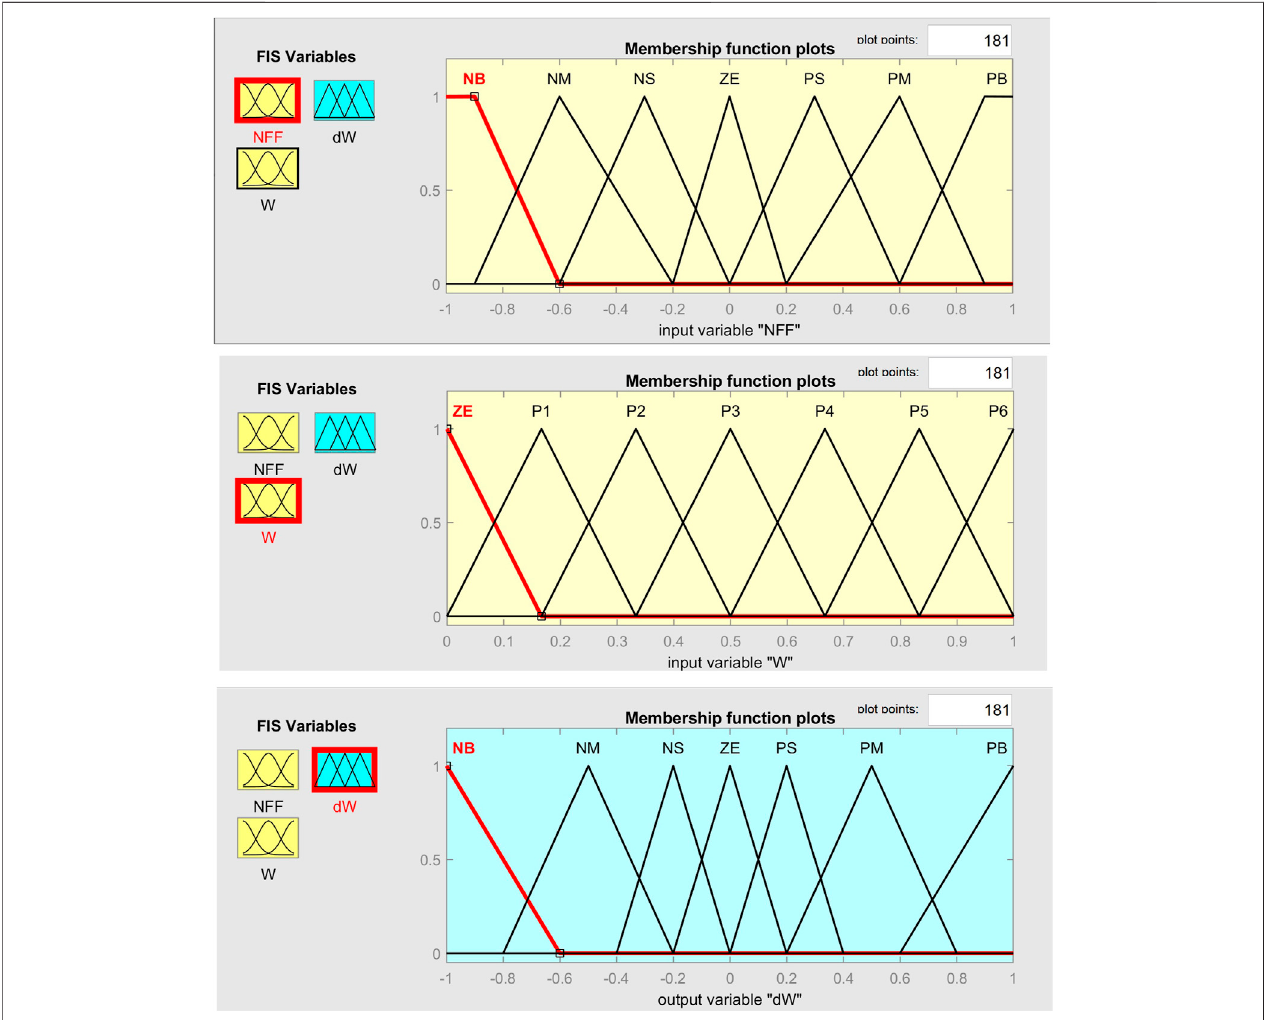
FIGURE 3 | Membership functions of the fuzzy